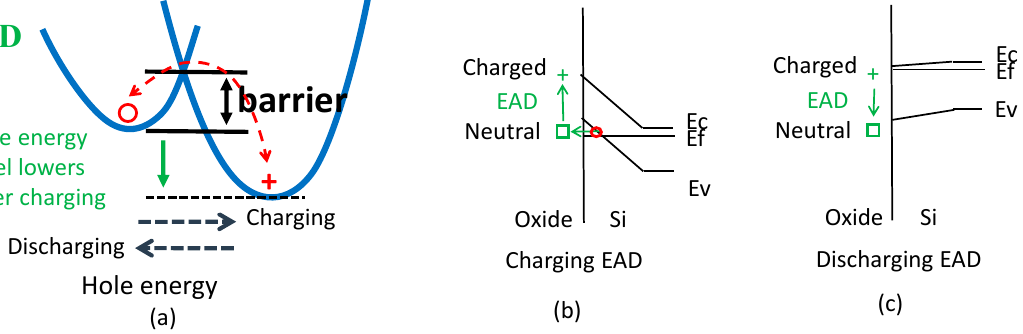
Figure 15. Charging and discharging EADs: ( a ) the hole energy level was lower following charging, which corresponded to a rise in its electron energy level in ( b ); ( c ) the electron energy level of the hole trap was lower after discharging. The symbol ‘ □ ’ represent a hole trap in its neutral state.